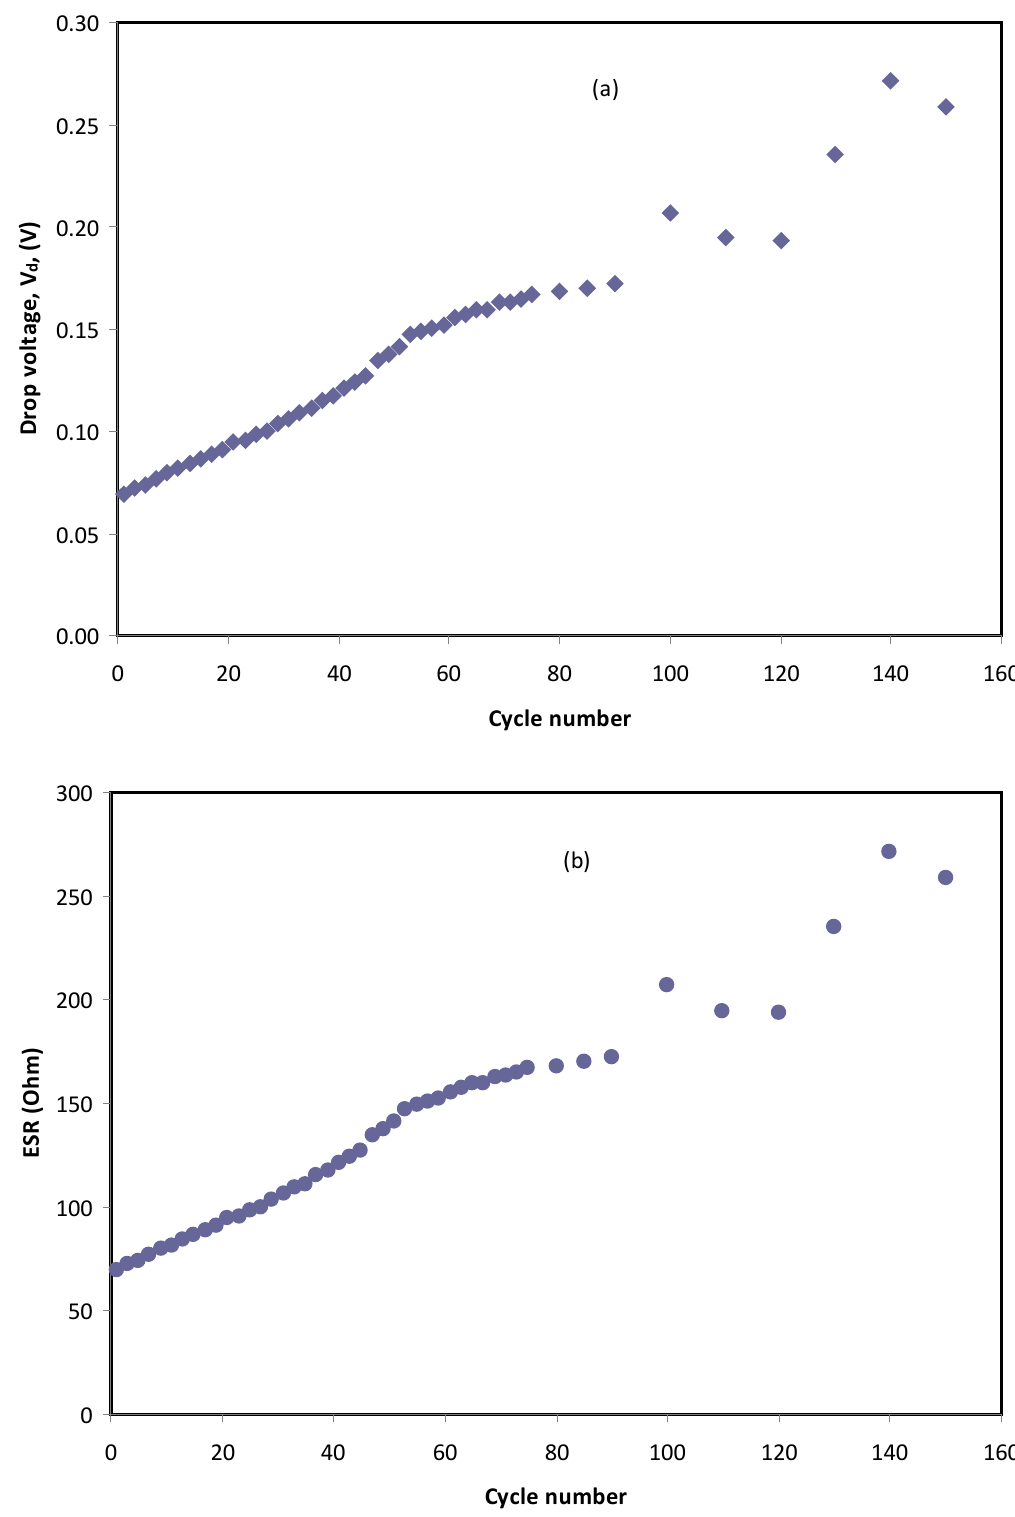
Figure 8. The EDLC parameters of ( a ) drop voltage ( V d ) of discharge process initiation, ( b ) equivalent series resistance (ESR) pattern up to 150th cycles.